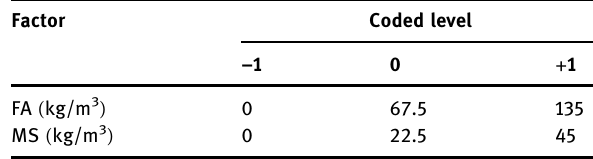
Table 1: Coding and experimental values of adopted